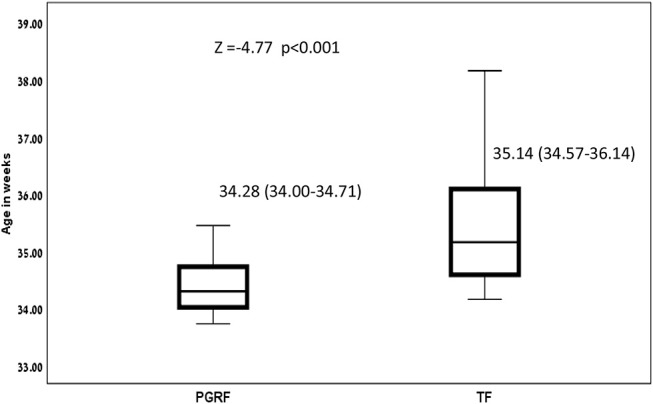
Age at full oral feeding among the study groups. Data are presented as median (P25-P75). Statistical analysis was based on Mann-Whitney test. PGRF, parental guided responsive feeding; TF, traditional feeding.